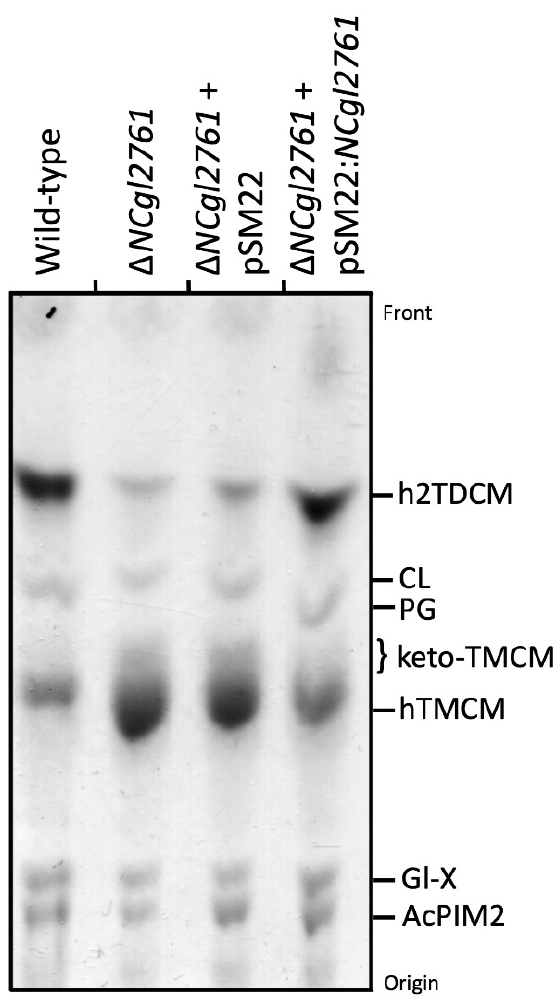
Figure 4. Cell wall free glycolipid analysis of a C. glutamicum ∆ NCgl2761 mutant. Lipids were extracted from WT C. glutamicum , ∆ NCgl2761 , ∆ NCgl2761 containing empty pSM22 and ∆ NCgl2761 containing pSM22: NCgl2761 , then analysed by HPTLC. Glycolipids were visualized by orcinol-sulfuric acid staining. The identities of glycolipids indicated were based on previously published reports. CL, cardiolipin; PG, phosphatidylglycerol; Gl ‐ X, Man.GlcA ‐ DAG; AcPIM2, Man 2 ‐ acyl ‐ PI. The accumulation of hTMCM in the ∆ NCgl2761 mutant could be explained by a de ‐ fect in hTMCM transport across the IM for conversion to h2TDCM. We therefore investi ‐ gated the subcellular distribution of hTMCM/h2TDCM in WT and the NCgl2761 mutant using differential solvent extraction, as previously described [17]. Extraction of bacteria with 1 ‐ butanol results in the selective removal of OM lipids such as TDCM, but not cell (inner) membrane lipids such as PI. For WT cells, approximately 75% of the hTMCM la ‐ belled with [ 14 C] ‐ acetate was extracted by the 1 ‐ butanol, indicating that a major fraction